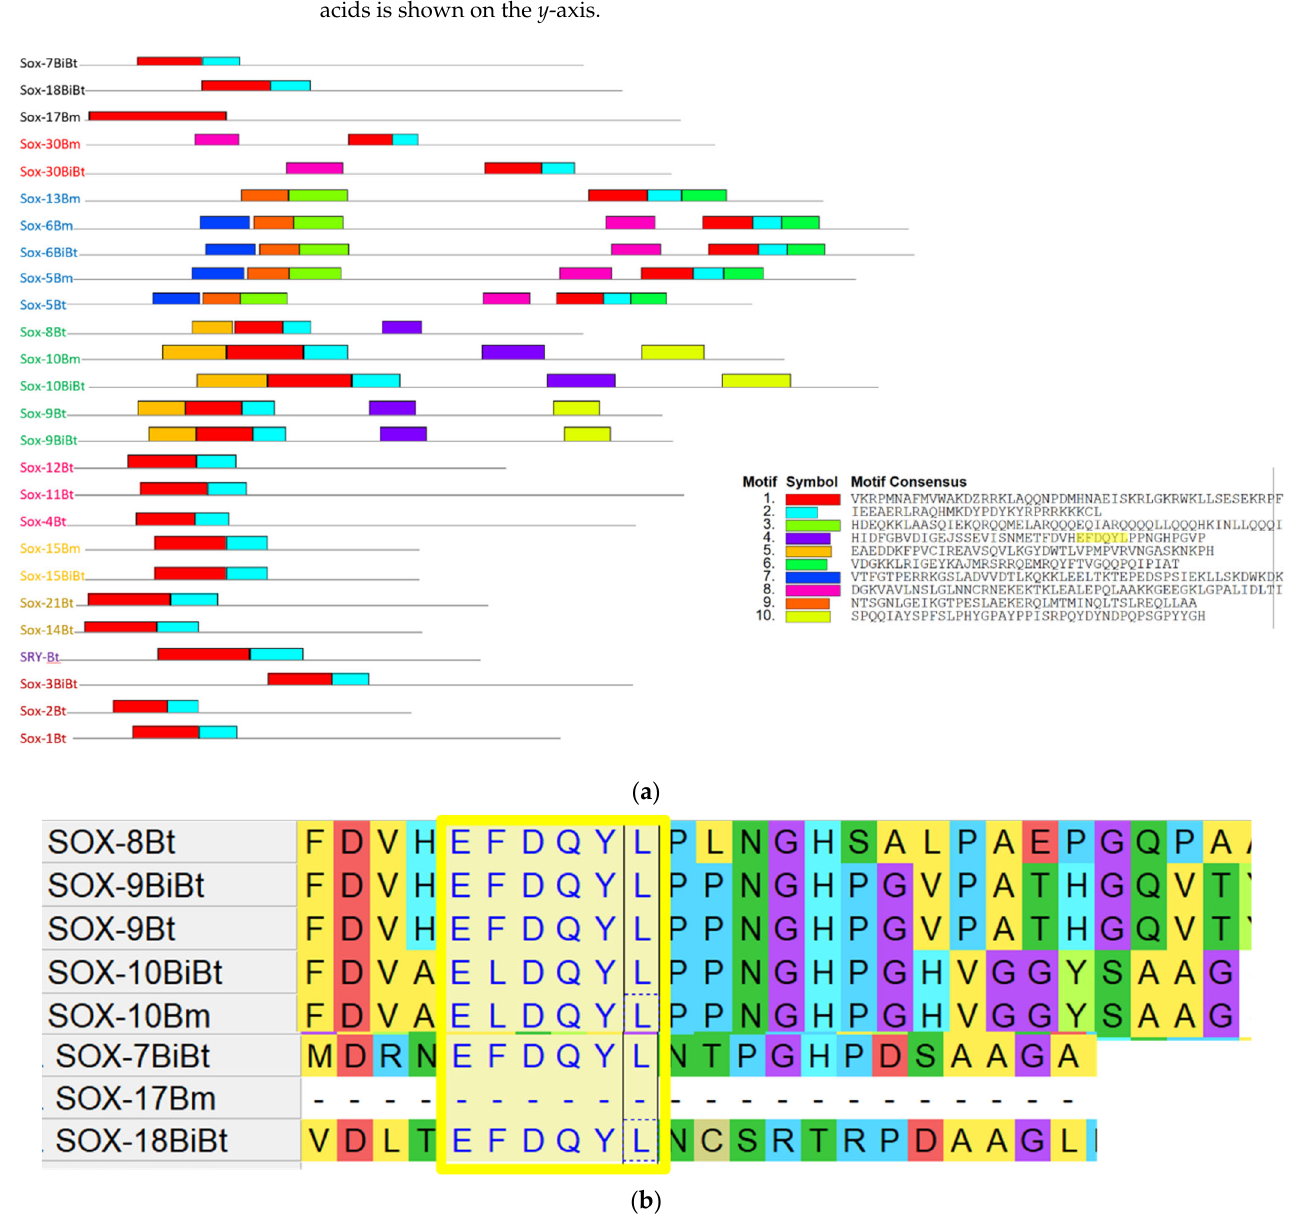
Figure 5. Logo plots of Sox protein sequences displaying the most conserved domain and positions of amino acids. A total of 26 multiple sequence alignments are represented using Weblogo (http://weblogo.berkeley.edu/logo.cgir accessed on 24 April 2022). The relative frequency of the amino acids is shown on the y ‐ axis.